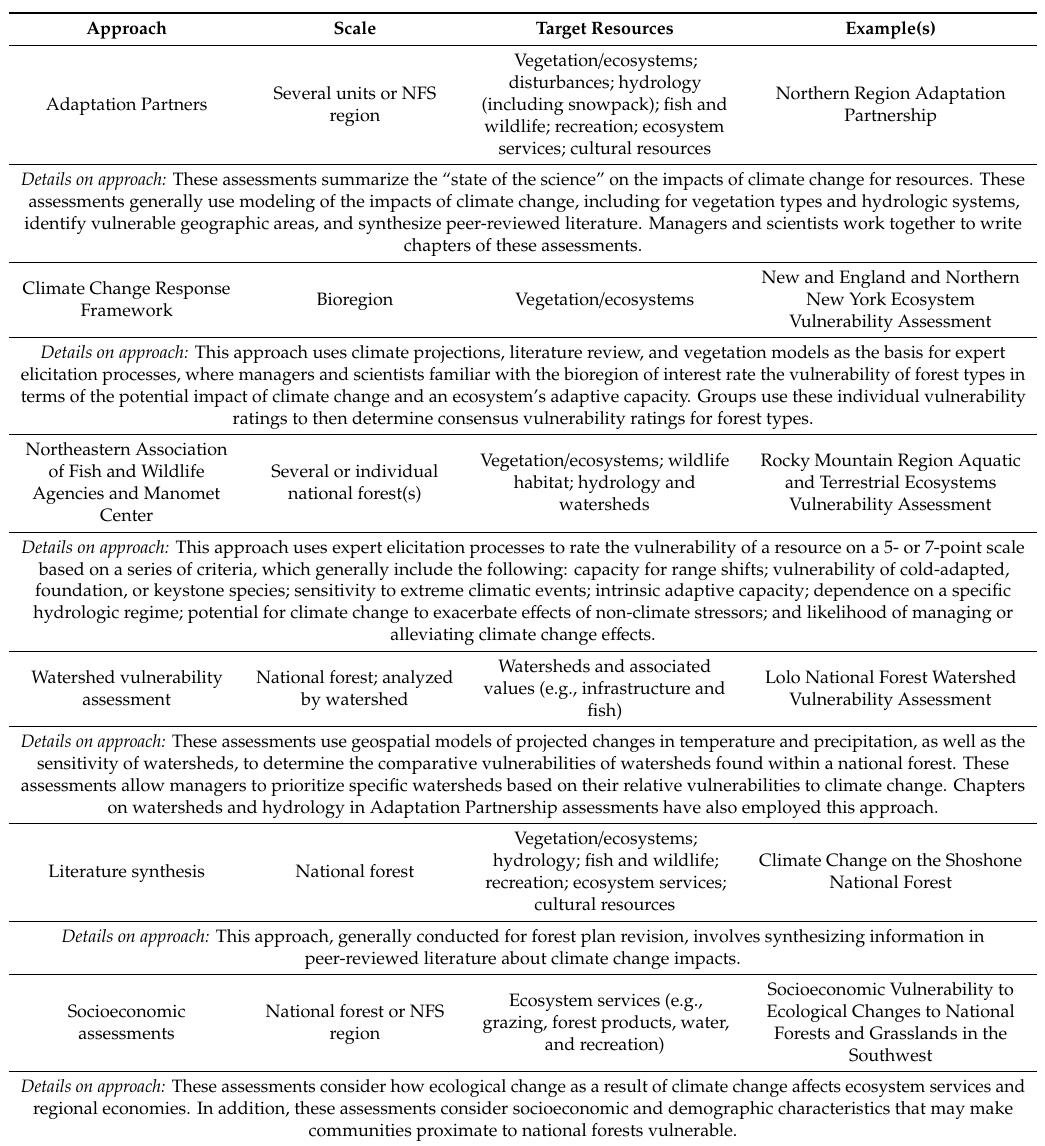
Table 2. Common types of vulnerability assessment approaches in use by the U.S. Forest